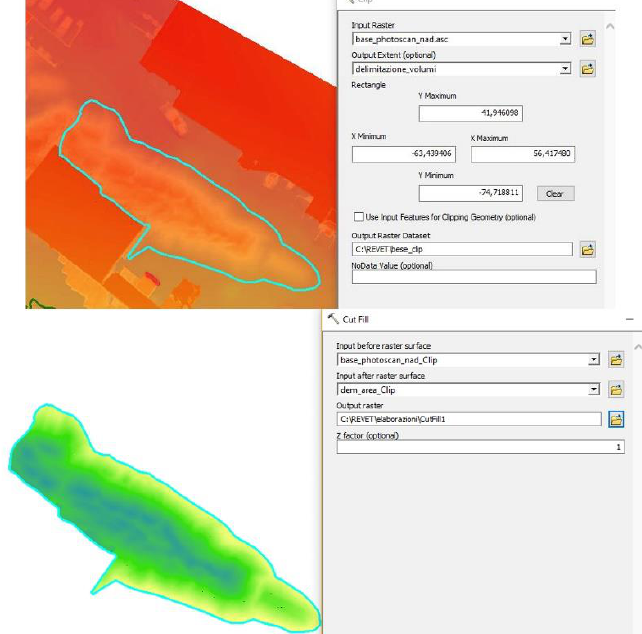
Figure 20. Pile importing with Clip and Cut Fill ArcGIS tools.